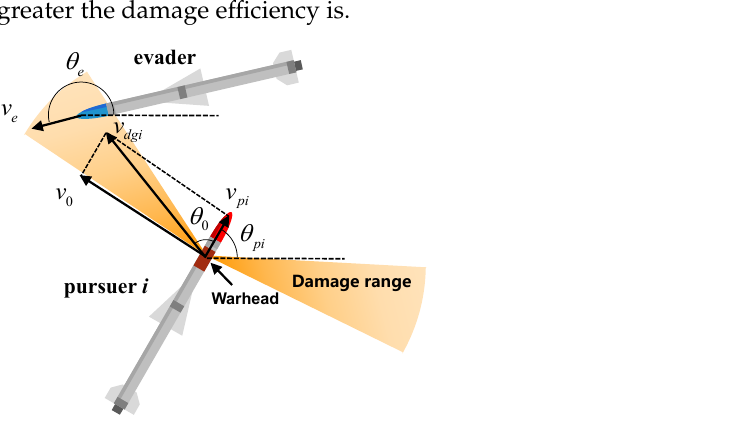
Figure 3. The relative motion of pursuer and evader in the ground coordinate